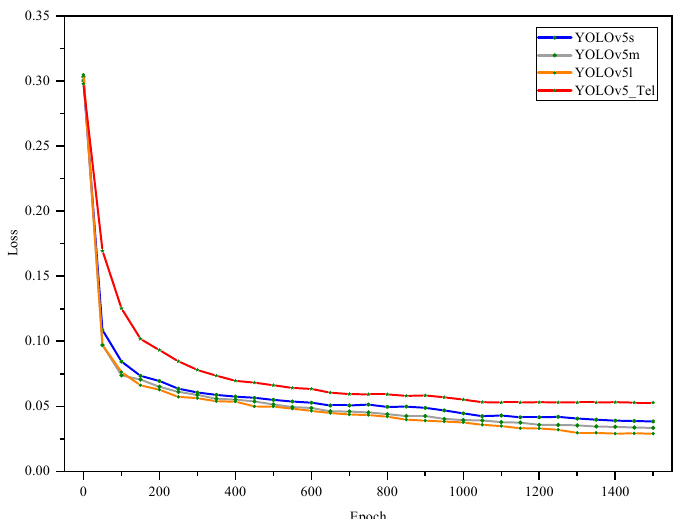
Figure 9. Convergence of loss functions for different models on the training set.